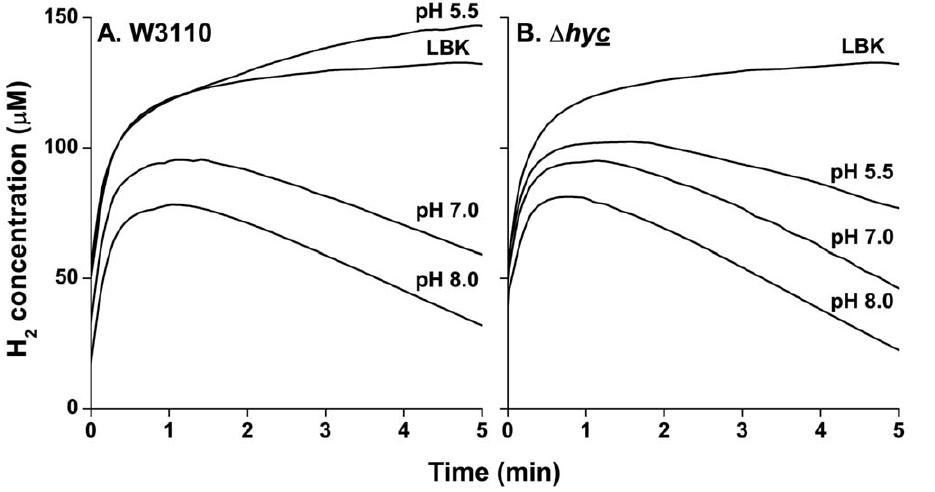
Figure 4. Effect of pH on the H 2 consumption by W3110 and D hycE . The lines represent traces of H 2 concentration as a function of time. Before time 0 the cultures were sparged with 20% H 2 /80% N 2 in order to saturate the culture with H 2 . Anaerobic cultures of W3110 ( A ) and D hycE ( B ) were grown to log phase at pH 5.5, pH 7, and pH 8 and assayed for H 2 consumption as stated in the Materials and Methods. A sample of LBK saturated with H 2 was assayed as a control to assess residual H 2 loss. Lines are representative samples of n=3.